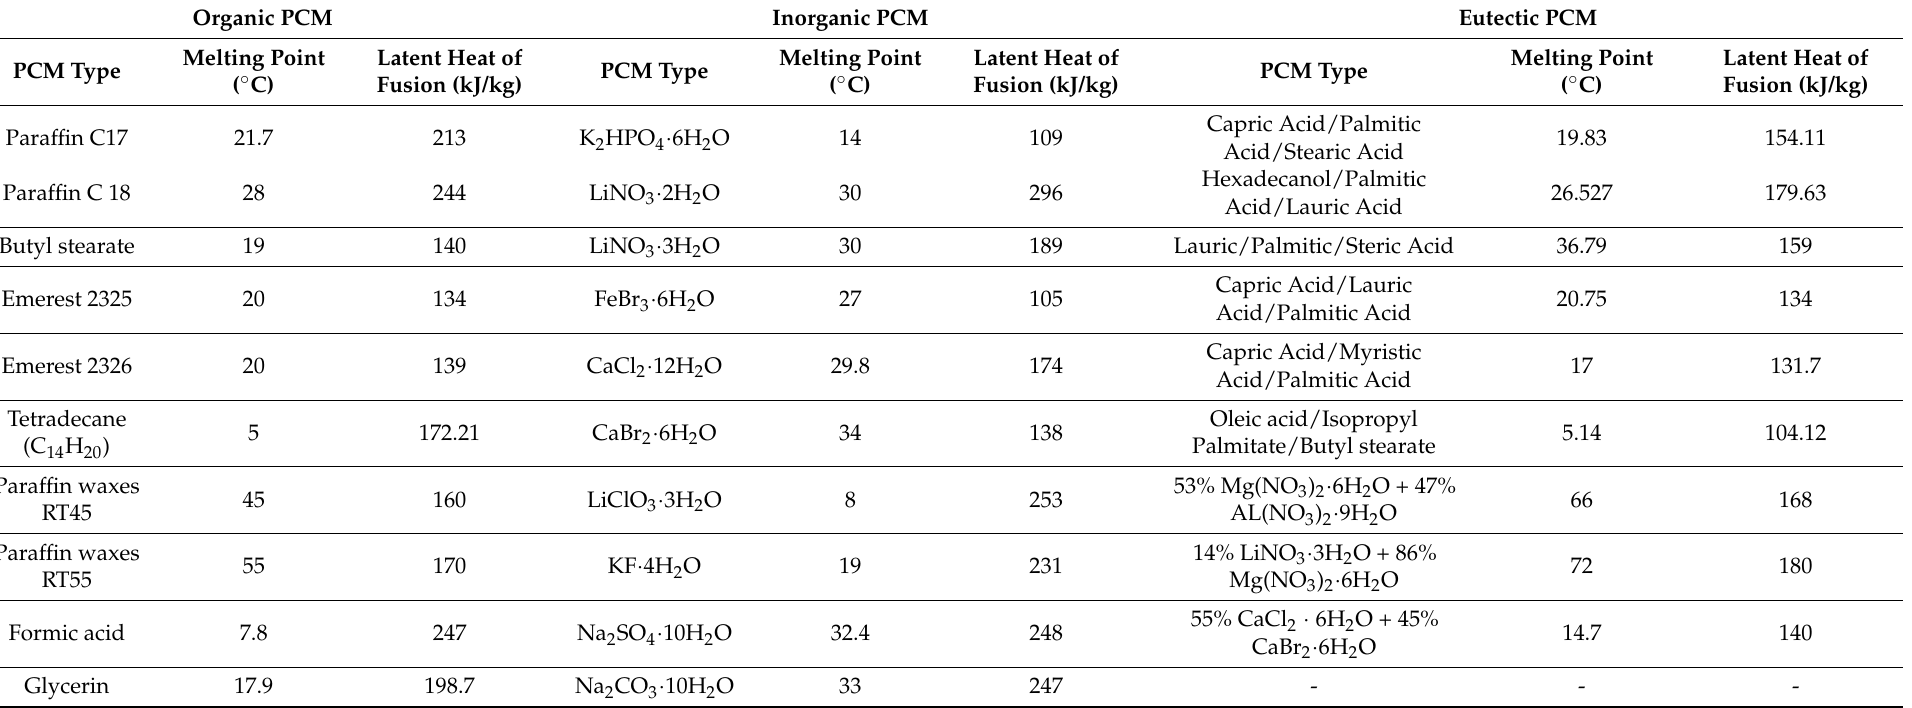
Table 1. Melting point and latent heat of different types of (a) organic [31,71–74], (b) inorganic [75–77], and (c) eutectic [64,65,78–81] type of